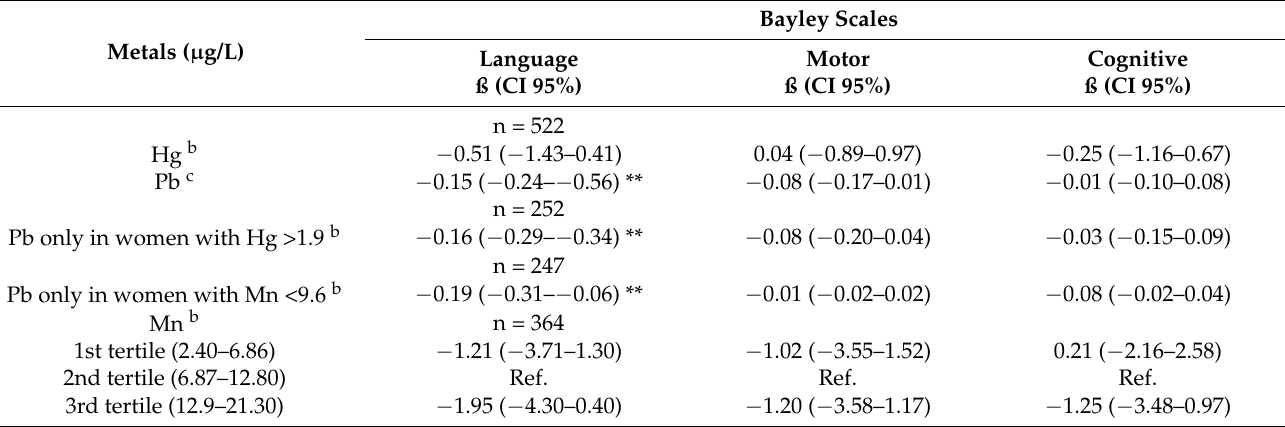
Table 2. Neurodevelopment association with prenatal blood lead, mercury, and manganese levels in 1 – 12-months-old children in Sonora, Mexico a.